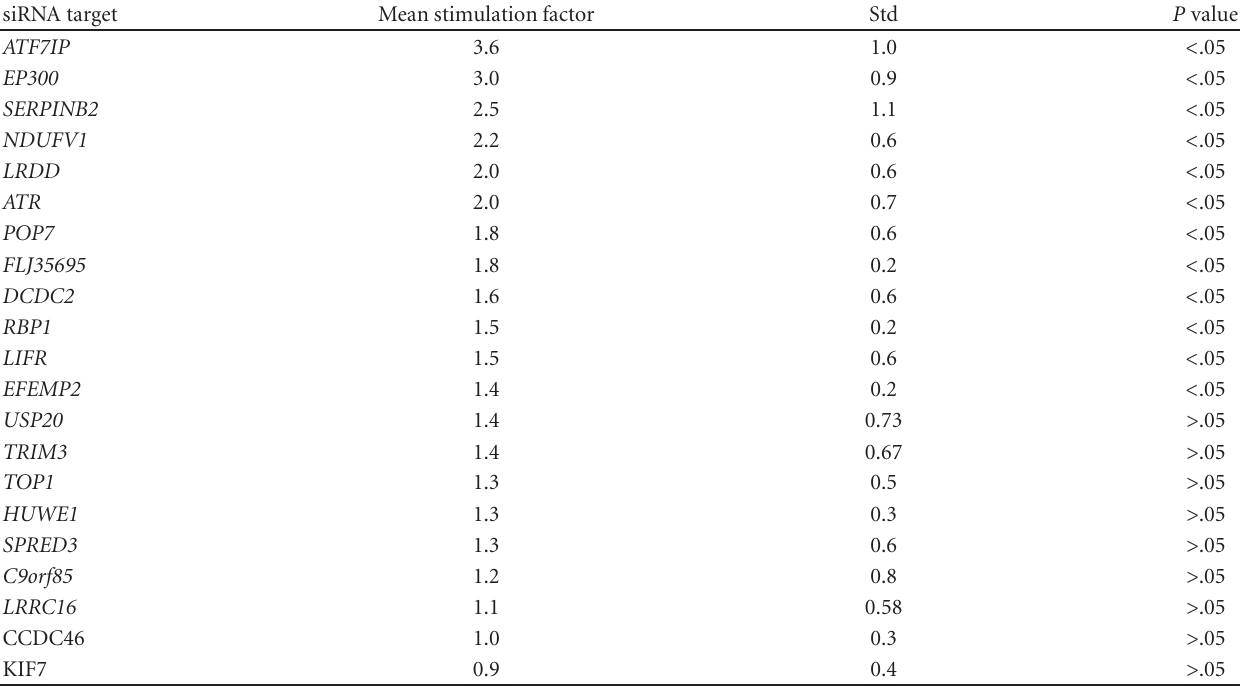
Table 1: Validation of the candidate genes. Candidate genes were selected after secondary screening. siRNAs targeting various mRNA sequences were tested for their ability to stimulate homologous gene targeting. Results are the means of at least 3 independent